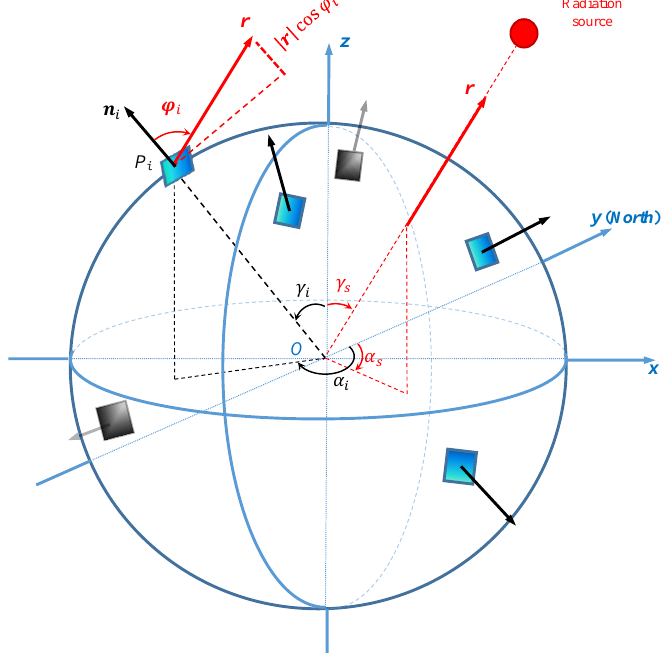
Figure 1. Geometric relationship of the Sun vector and the sensor array in an sphere coordinate system, where the sensor array aligns with the x-y-z coordinate of the spacecraft, the Sun vector r has an azimuth angle α s and zenith angle γ s , the sensor plane P i has an azimuth α i and zenith γ i , the unit normal direction of the sensor plane n i points towards local vertical direction with an angle ϕ i between r and n i